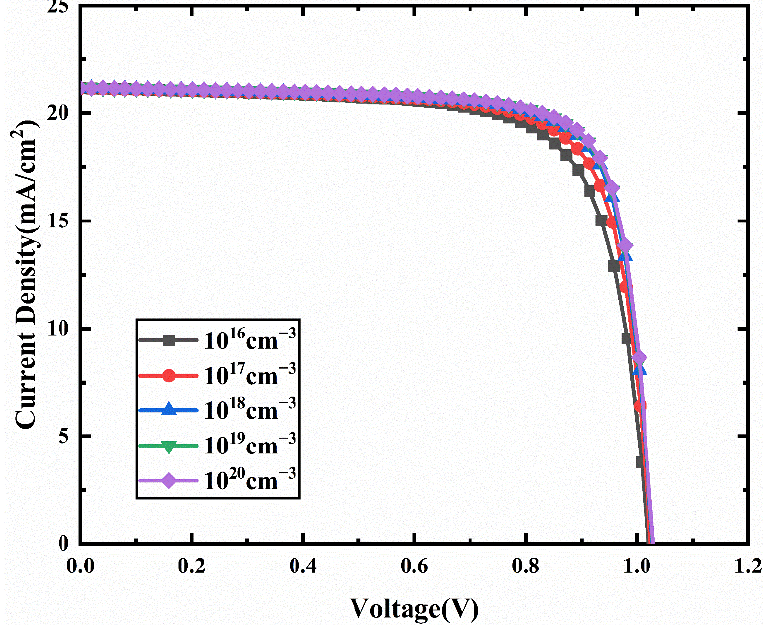
Figure 7. Comparison of J-V characteristic curves for different acceptor density (N A ).